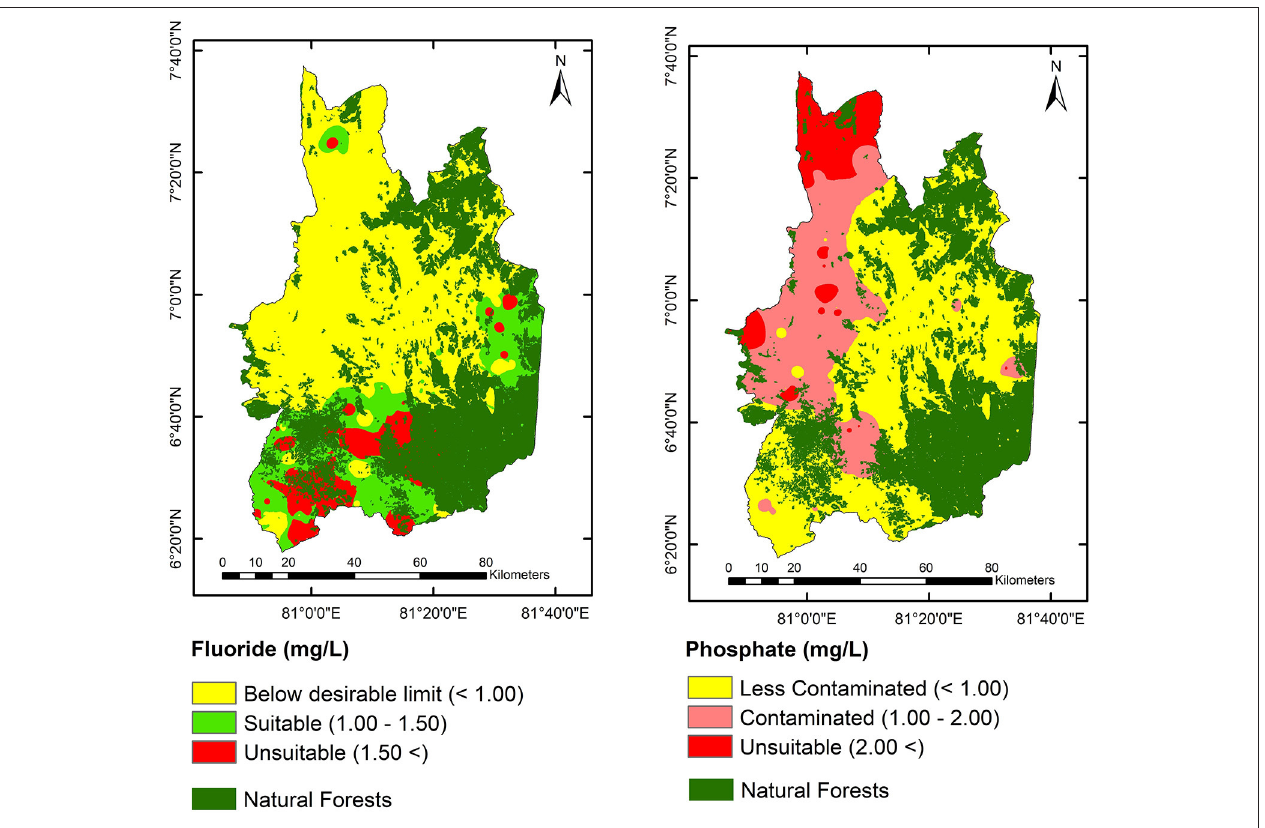
FIGURE 5 | Maps showing the spatial distribution of F − and PO − 3 4 in the study